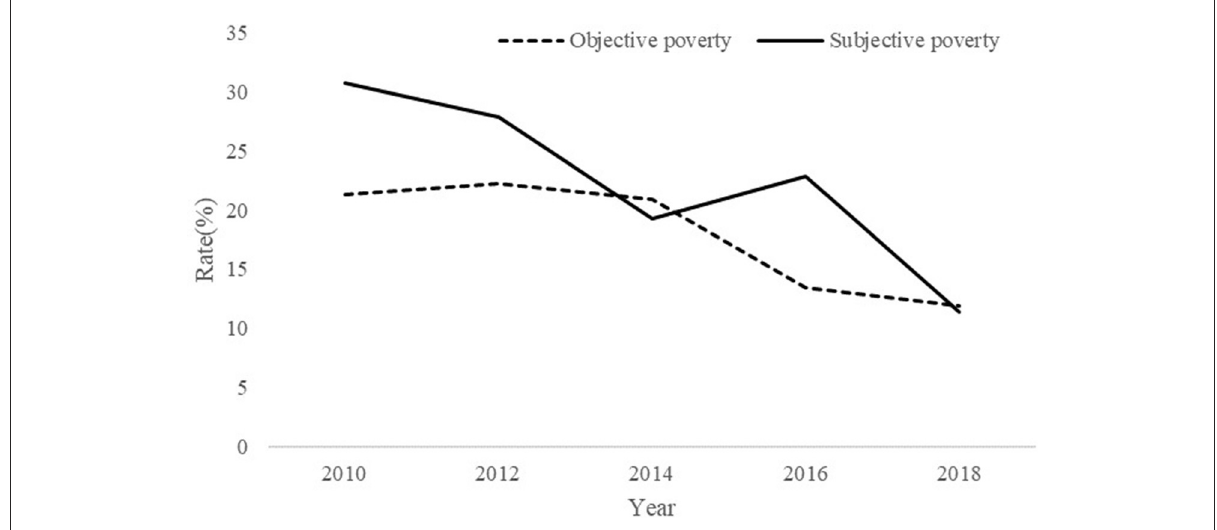
FIGURE1 Rate of subjective poverty and objective poverty from 2010 to 2018.